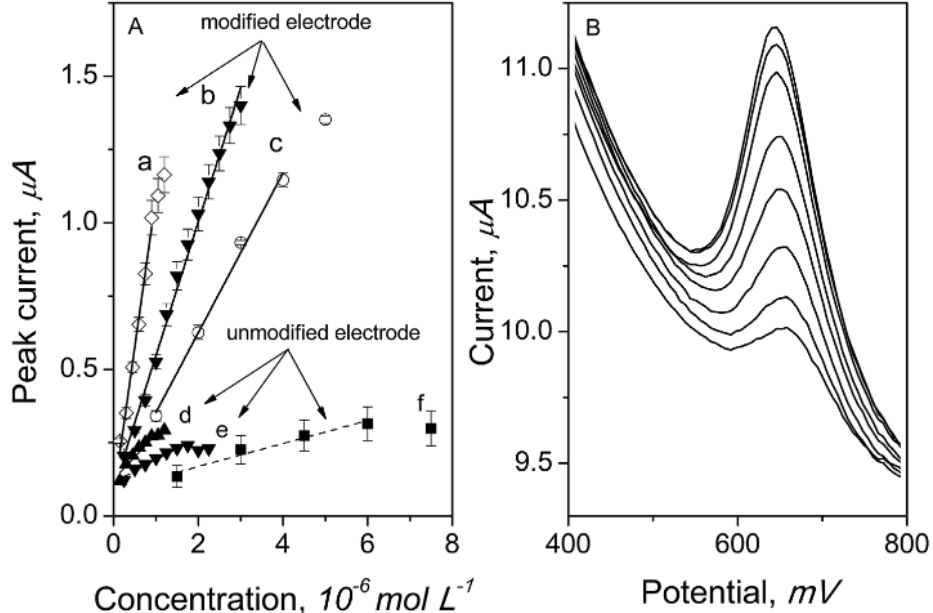
Figure 3. Estradiol calibration graphs ( A ) with corresponding voltammograms for the preconcentration time of 60 s ( B ) measured on a glassy carbon electrode modified with carbon black [245]. The following curves in picture A stand for preconcentration times: a: 60 s, b: 20 s and c: 5 s, measurements carried out in the 0.1 mol L − 1 phosphate buffer pH 6.2. Reprinted from Glassy carbon